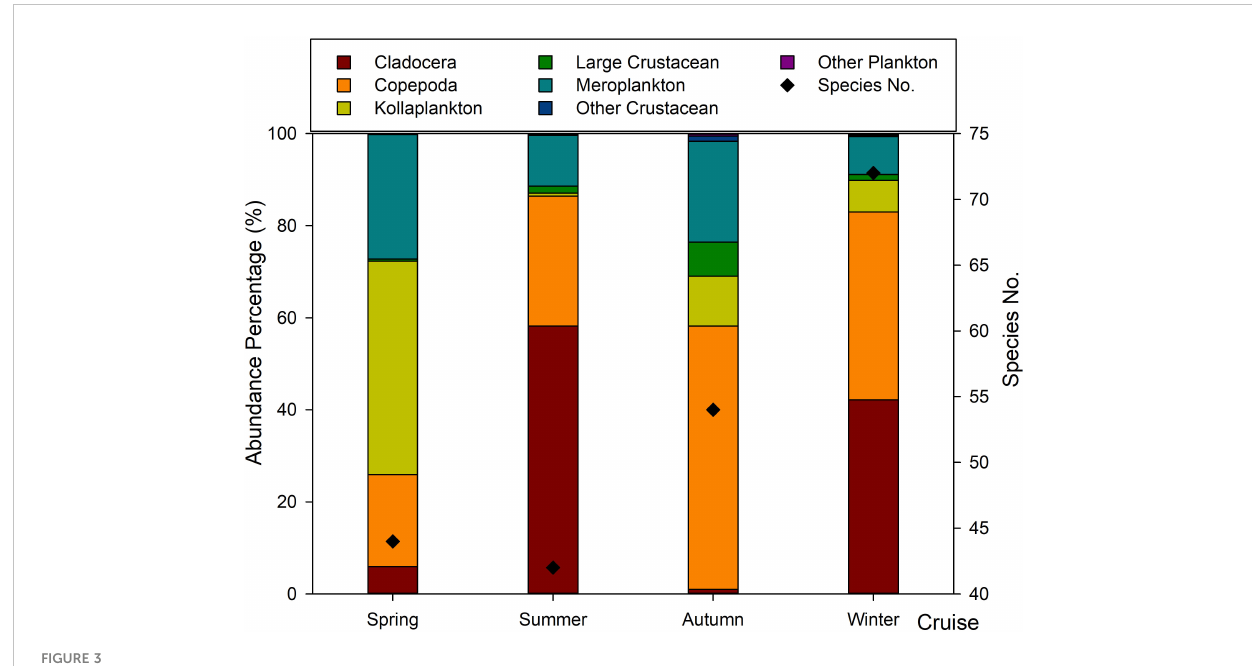
FIGURE 3 Species number and abundance percentage in Daya